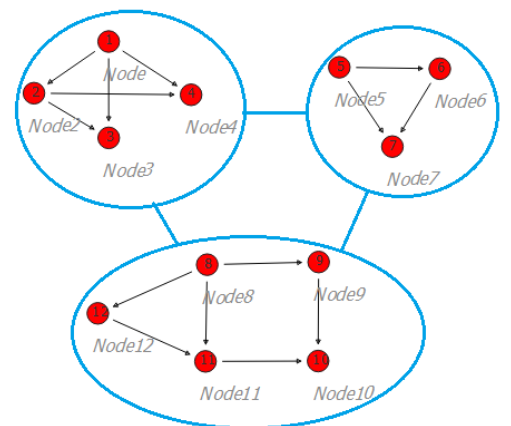
Figure 1. A simple graph with three communities, enclosed by the